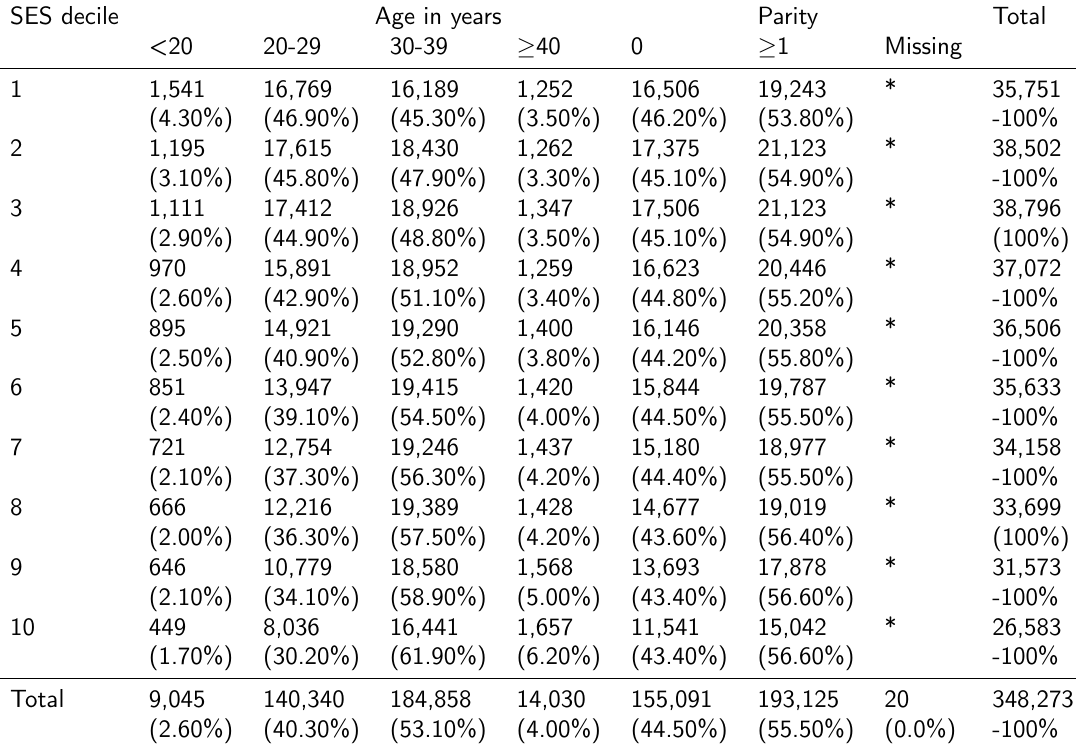
Table 1: Maternal traits by socio-economic status